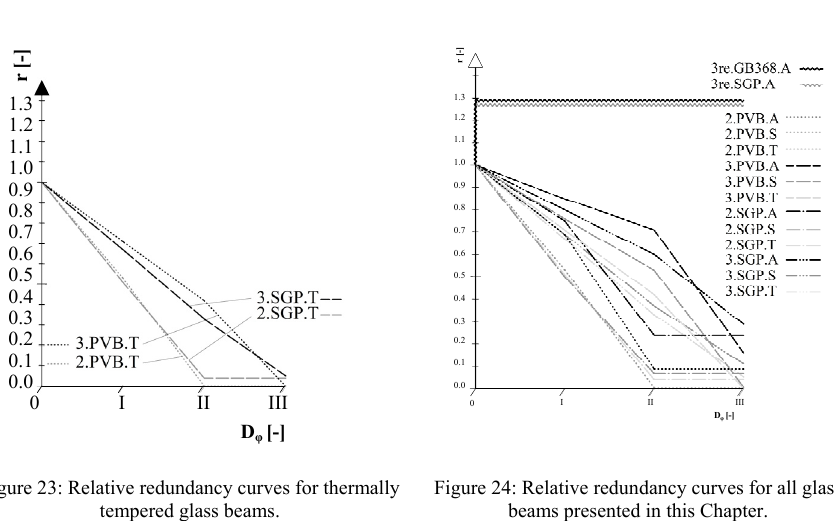
Figure 21: Relative redundancy curves for annealed glass beams.